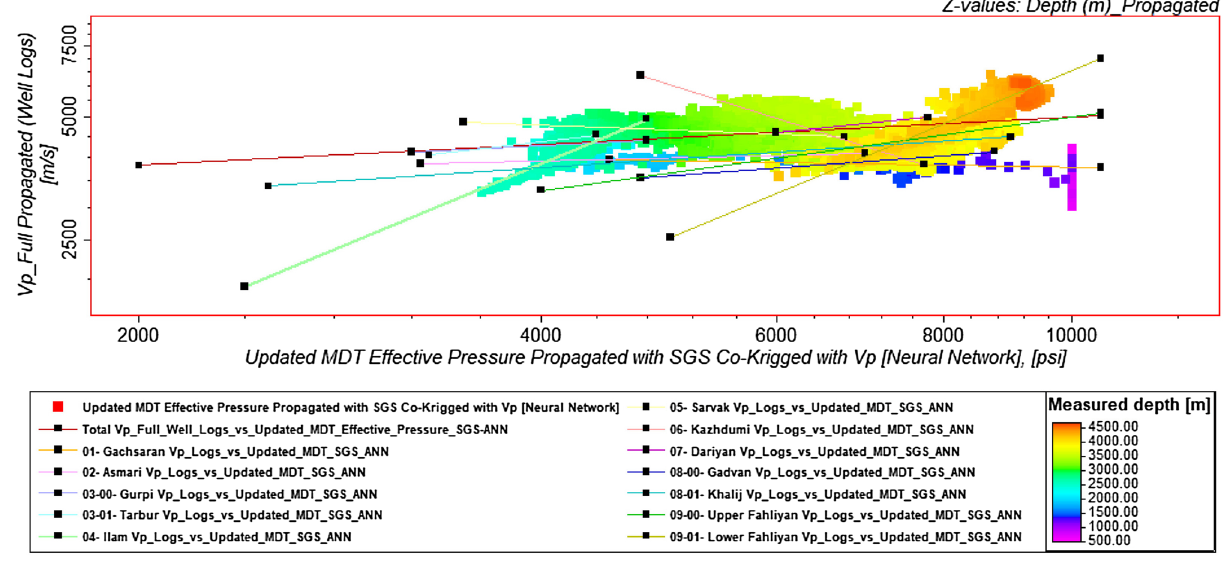
Fig. 9 Correlation coefficients of the final effective pressure model with the velocity cube model (update of the Bowers relation coefficients) in the whole